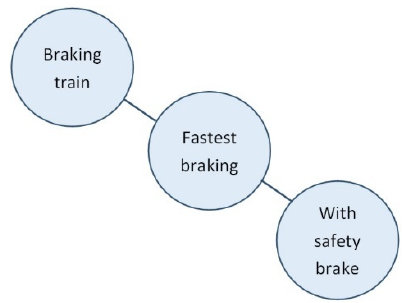
Figure 9. Knowledge structure minimal braking distance.